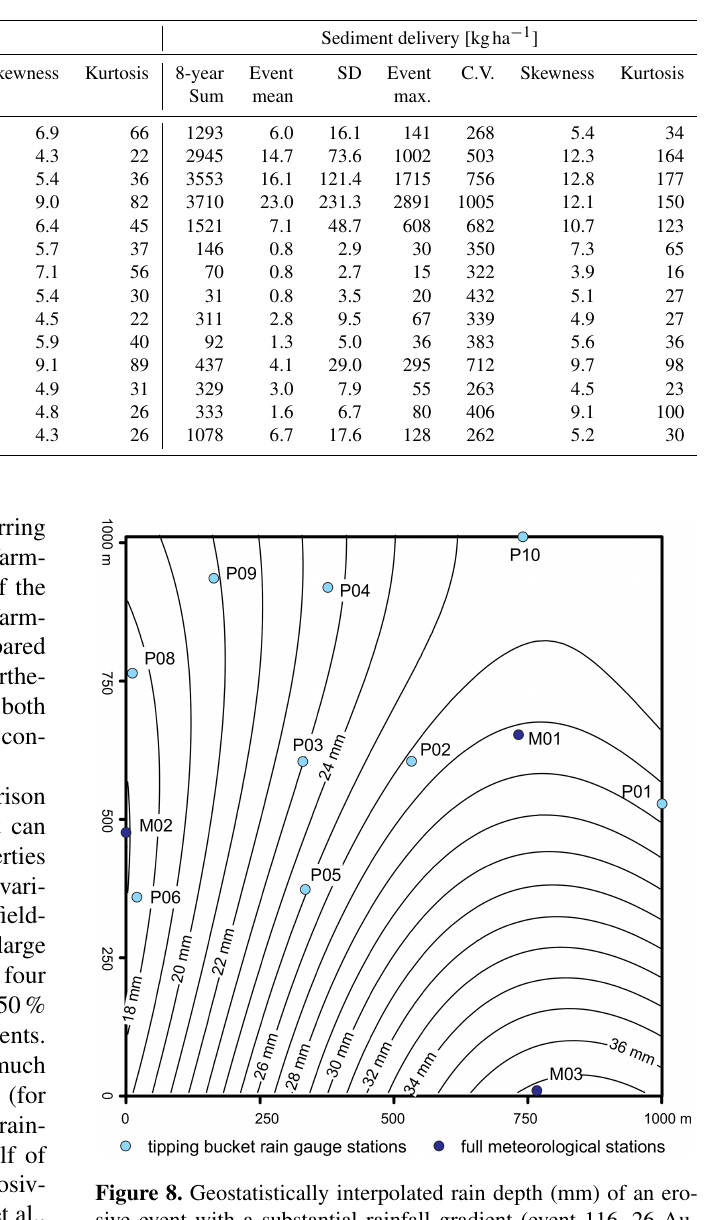
Table 3. Characteristics of measured surface runoff and sediment delivery events (W01 ... W07, W10, W12 ... W16: 1994–2001; W11: 1998–2001) in the different watersheds; C.V. is coefficient of variation. “Sum” is the total of eight years while all other columns are event based. In total 287 events were recorded that produced runoff in at least one of the watersheds.